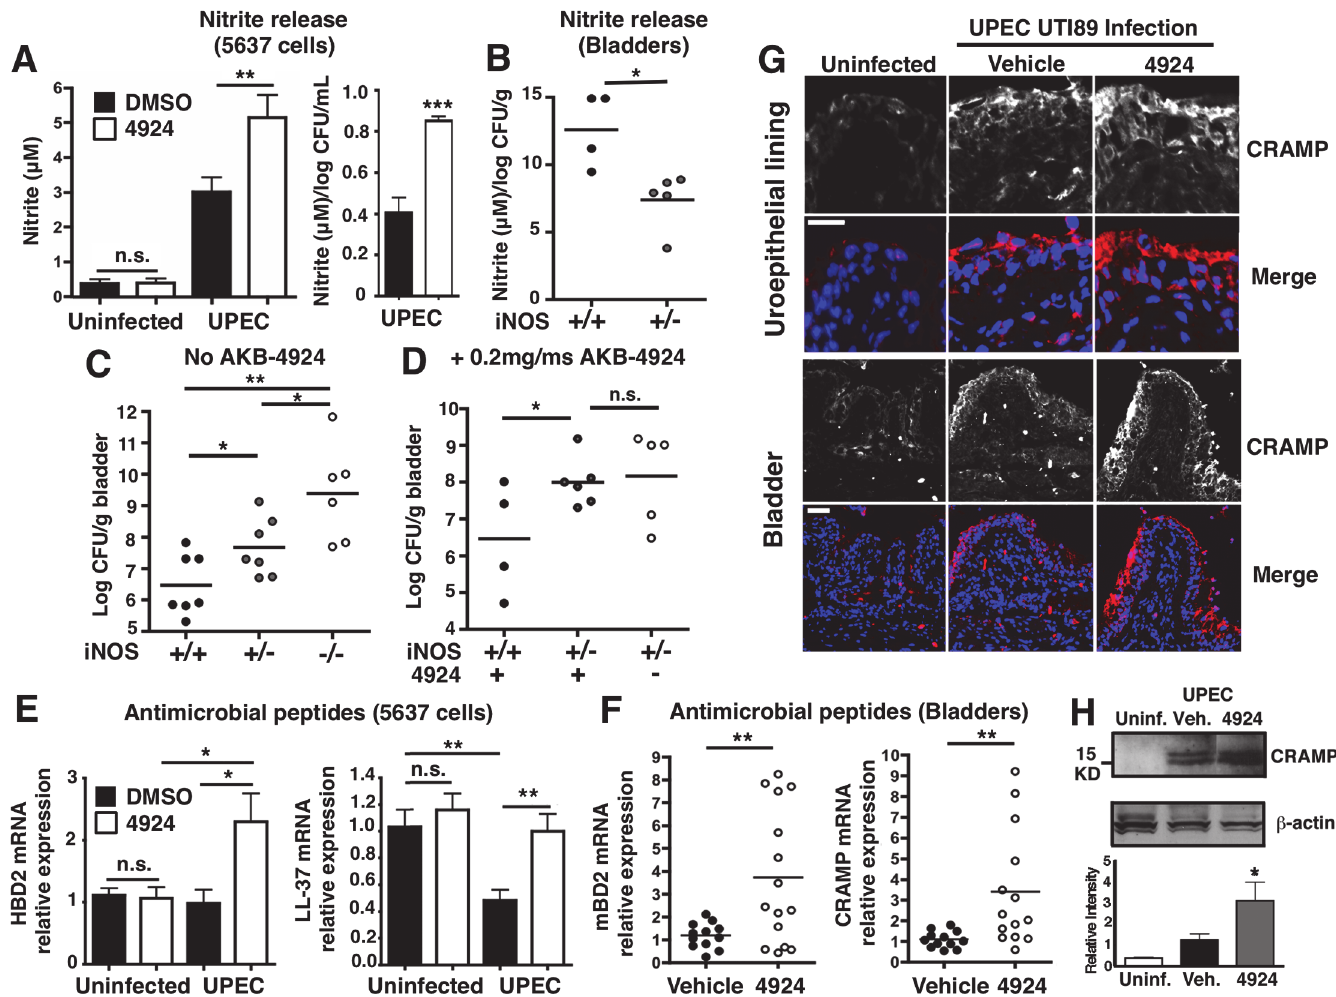
Fig 6. AKB-4924 pretreatment enhances production of nitric oxide and host defense peptides during UPEC infection. ( A ) Nitrite production from AKB-4924 treated 5637 cells was significantly higher than from DMSO treated cells 2 h post-infection. (Uninfected, n = 6; UPEC CFT073 infected, n = 12). Left panel: Absolute nitrite production ( μ M). Right panel: Relative nitrite productions per log CFU per mL (n = 6). ( B ) Nitrite released from WT (iNOS +/+) and heterozygous (iNOS +/-) per log CFU per bladder (gram) (n = 4 – 5) ( C ) WT (iNOS +/+), iNOS+/- and iNOS-/- C57BL/6 mice were infected with UPEC CFT073 for 18 – 24h before bladders were harvested for CFU enumeration (n = 7, 6). ( D ) WT and iNOS +/- C57BL/6 mice were pre-treated with 0.2 mg AKB-4924 or ω ehicle for 1 h followed by infection with UPEC CFT073 (n = 4 – 6). ( E ) Human AMP β -defensin 2 (hBD2) (n = 8) and cathelicidin LL-37 (n = 7 – 10) mRNA level in UPEC CFT073 infected 5637 cells. Results were normalized to β -actin. ( F ) Real-time qPCR shows murine AMP β defensin 2 (m β D2) and CRAMP mRNA level in bladders (n = 10 – 12). Error bar = S.E.M ** P < 0.01, * P < 0.05, Student ’ s two-tailed unpaired t-test. ( G ) Representative images illustrating the distribution of murine cathelicidin (red) and nuclei (DAPI, blue) in the mucosa of UTI89 infected bladders with vehicle or AKB-4924 pre-treatment (n = 6). Upper panel scale bar = 50 μ m. Bottom panel: higher magnitude focused on the uroepithelial cell layer of bladder. Scale bar = 25 μ m. ( H ) Representative western blot of mouse bladder left uninfected (n = 2) or infected overnight with UPEC CFT073 (n = 3). Infected animals were pre-treated with vehicle or AKB- 4924 for 2 h. Relative level of cathelicidin level was measured using Image J and normalized to β -actin from 2 independent western blot experiments (2 – 3 different animals in each western